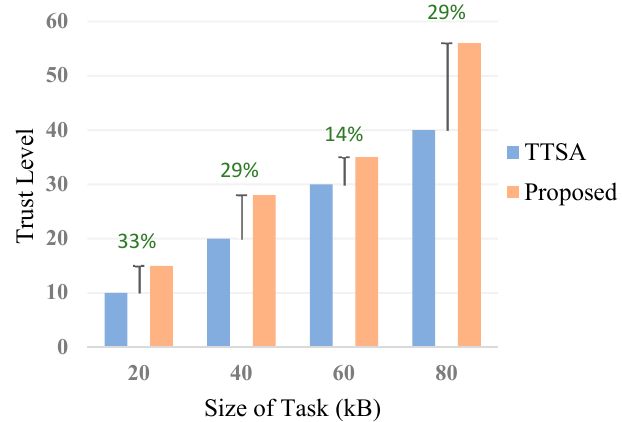
Figure 8. Comparison of service reliability.